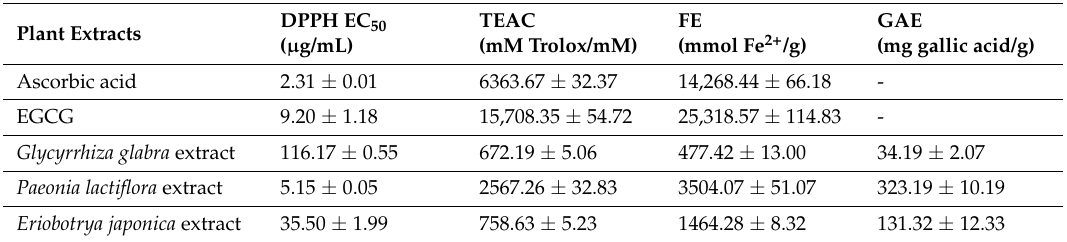
Table 4. The in vitro antioxidant capacity and total phenolic content of the plant